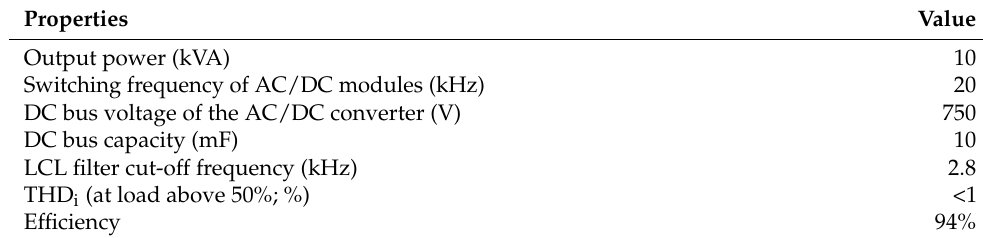
Figure 7. Simplified algorithm of multi-resonant converter control for single phase. Table 2. Hybrid AC/DC converter parameters.